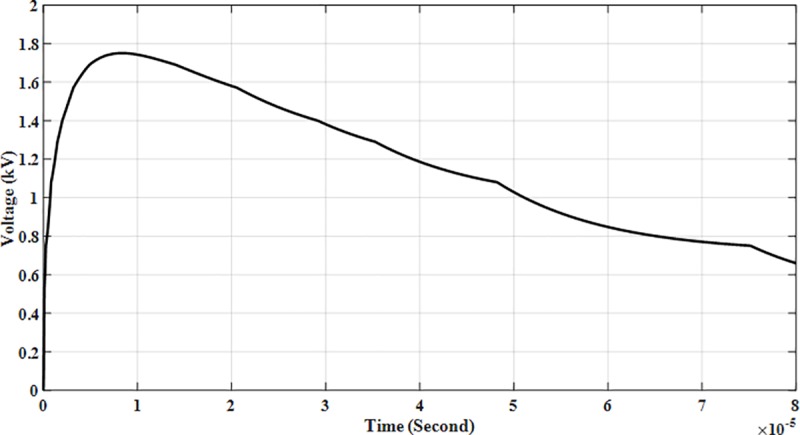
Arrester discharge voltage at In, 20 kA.